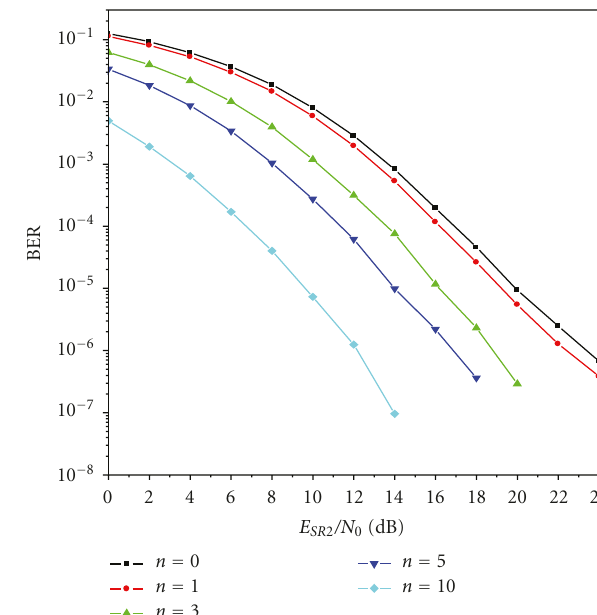
Figure 3: BER performance of DSTBC with di ff erent values of n - factor over Rician fading